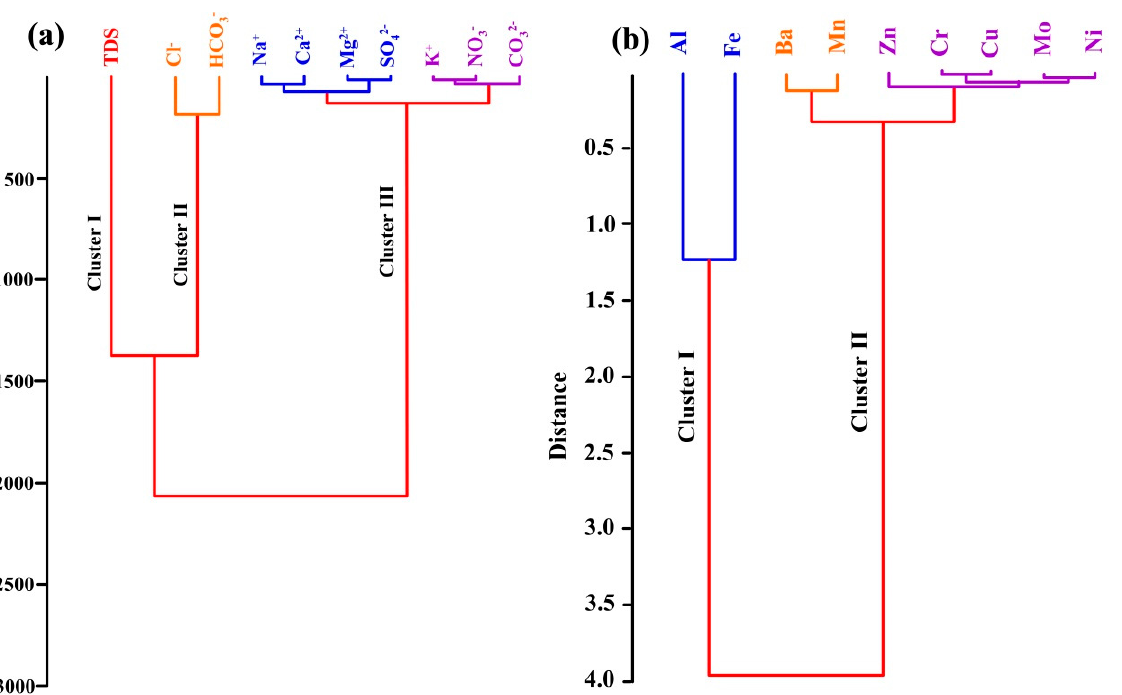
Figure 7. Cluster analysis for physicochemical parameters along the Nile River: ( a ) CA for major ions and ( b ) CA for metals.